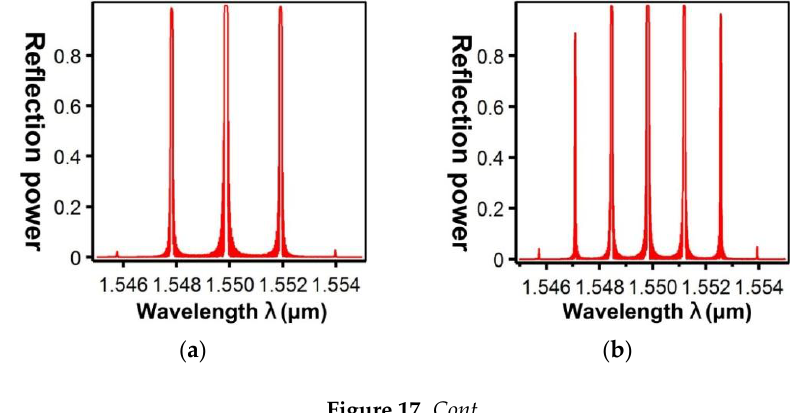
Figure 17 Cont . Figure 17.